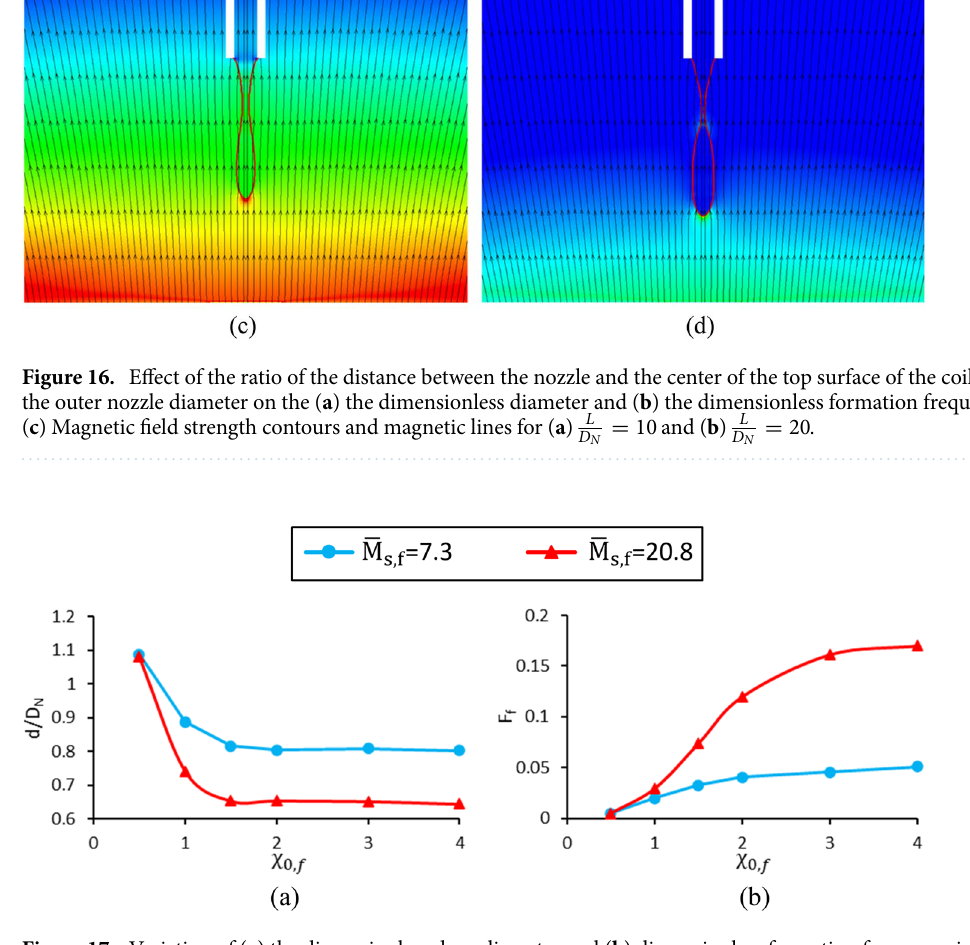
Figure 17. Variation of ( a ) the dimensionless drop diameter and ( b ) dimensionless formation frequency in terms of the initial magnetic susceptibility and various dimensionless saturation